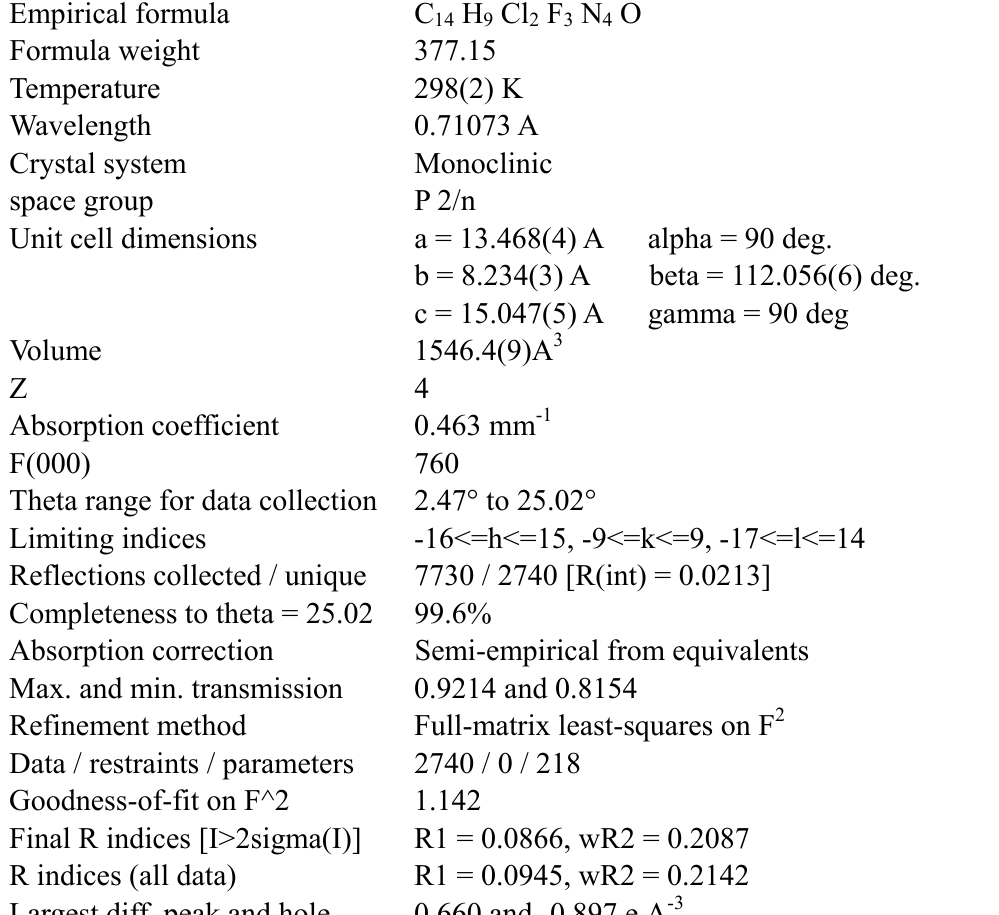
H Cl F N 14 9 2 3 4